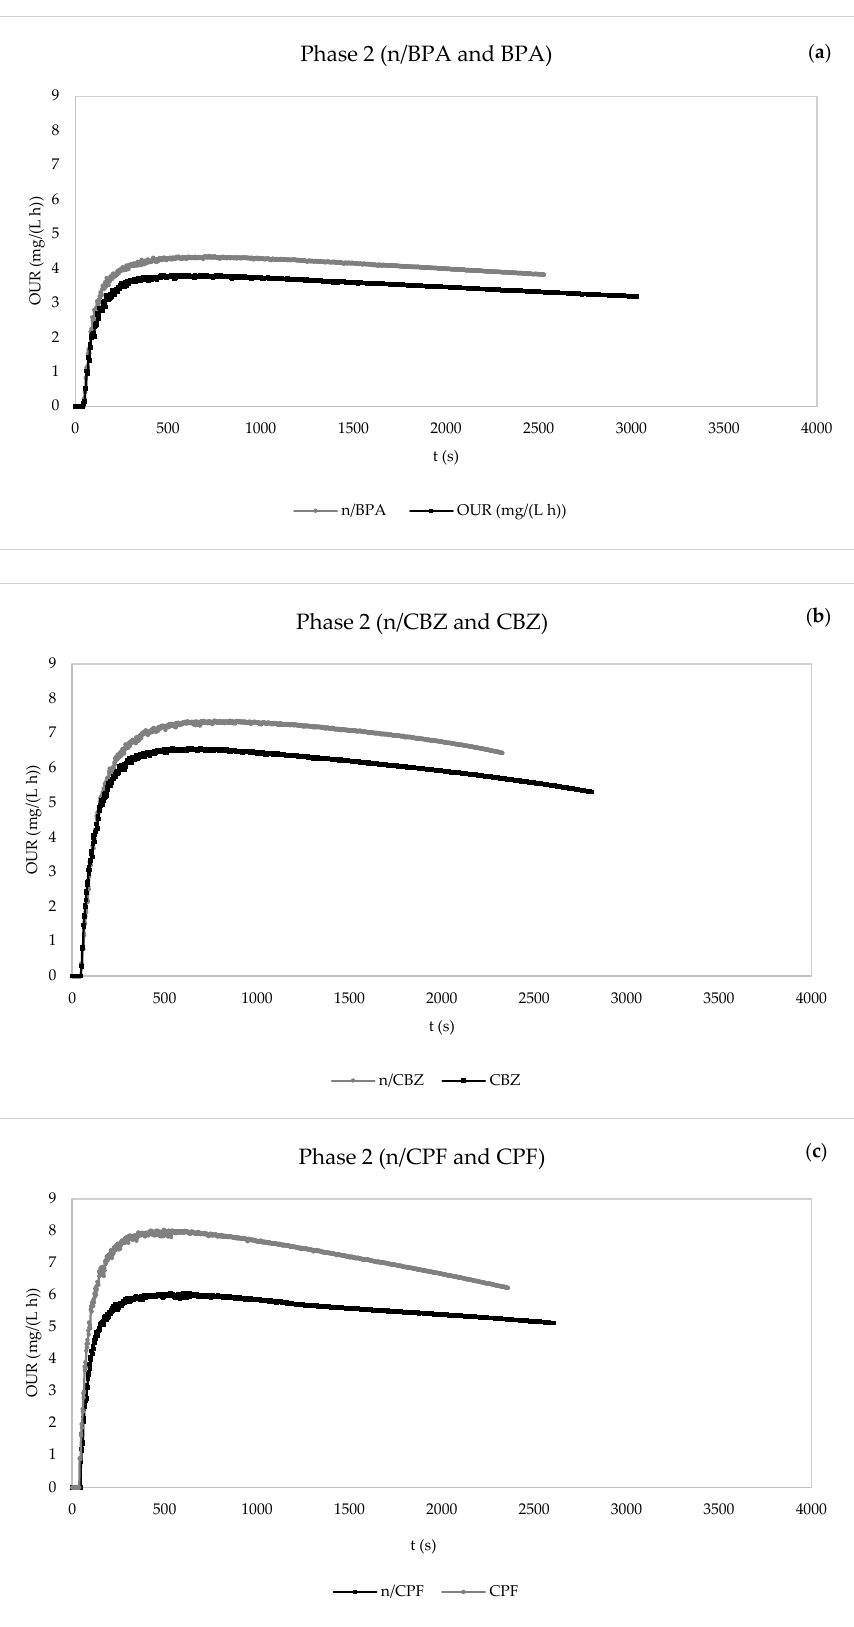
Figure 6. Evolution of static oxygen uptake rate (OUR) in the respirometric experiments in the ab- sence and presence of pollutants for the determination of the kinetic parameters. ( a ) Phase 1: control without BPA and with BPA. ( b ) Phase 1: control without carbamazepine and with carbamazepine. ( c ) Phase 1: control without ciprofloxacin and with ciprofloxacin. ( d ) Phase 1: control without phar- maceuticals and with mixture of pharmaceuticals. n/BPA: absence of bisphenol A. BPA: presence of bisphenol A. n/CBZ: absence of carbamazepine. CBZ: presence of carbamazepine. n/CPF: Absence of ciprofloxacin. CPF: Presence of ciprofloxacin. n/Mix: absence of mix of pharmaceuticals. Mix: presence of mix of pharmaceuticals.